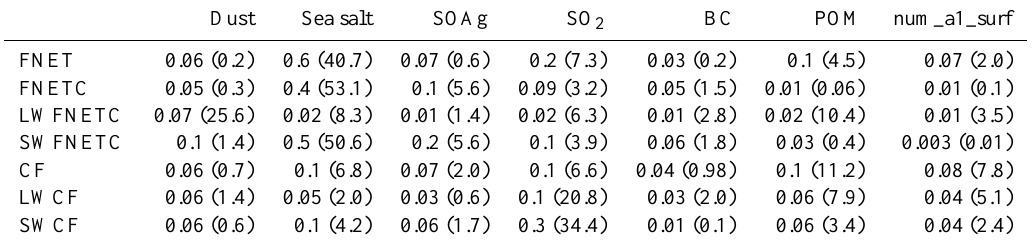
Table 2. Normalized changes of radiative fluxes due to perturbations of emission parameters in CAM5. The values in parenthesis are the relative contributions (%) of parameter perturbations to the total variance of FNET resulting from perturbation of emission parameters.